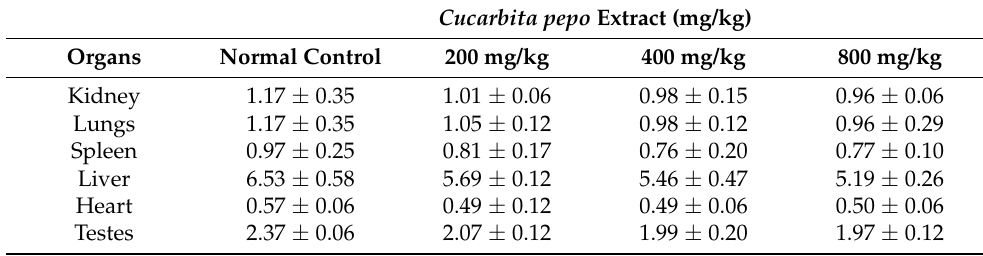
Figure 2. Body weight measurements of male rats treated with aqueous leaf extract of C. pepo for 14 days.